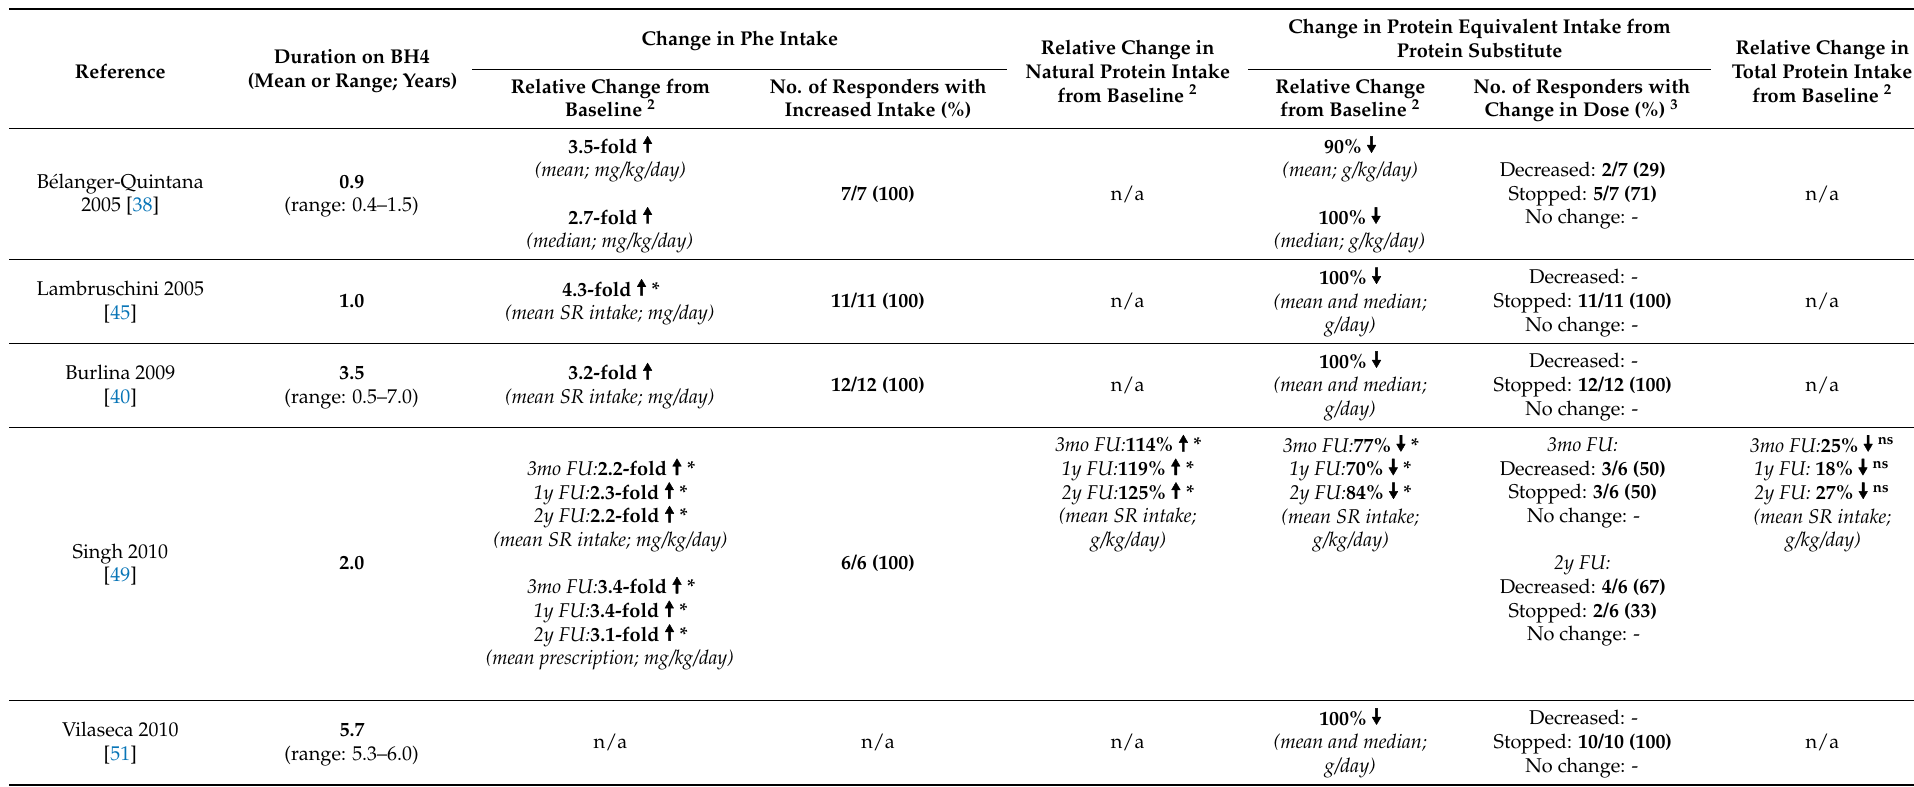
Table 2. Overview of study results: changes in phenylalanine and protein intakes (total protein, natural protein, and protein equivalent from protein substitute) of long-term responders on tetrahydrobiopterin (BH4) treatment 1 .